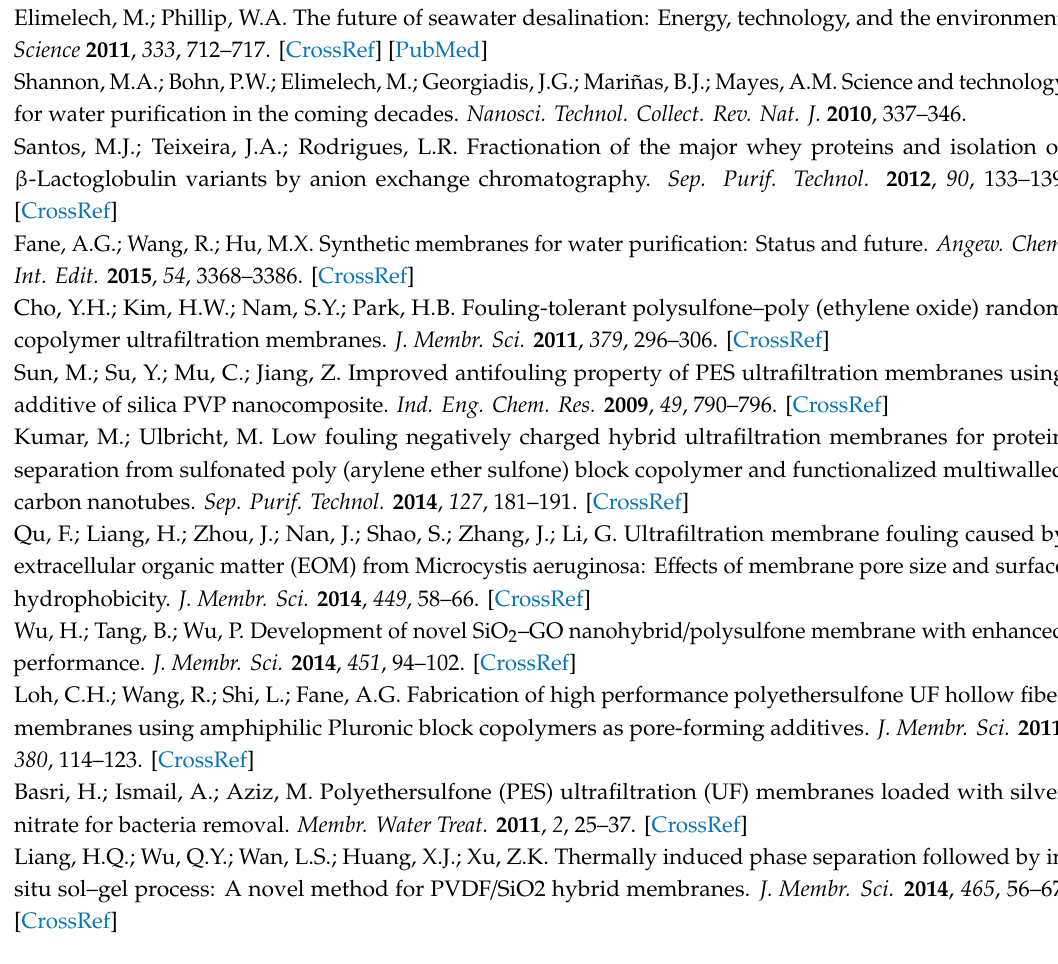
Figure S1: Porosity and mean pore size of (A) Z1, (B) B1, and (C) B2 membranes, Figure S2: TGA curves of B2 Base and B2 32:1 membrane in nitrogen